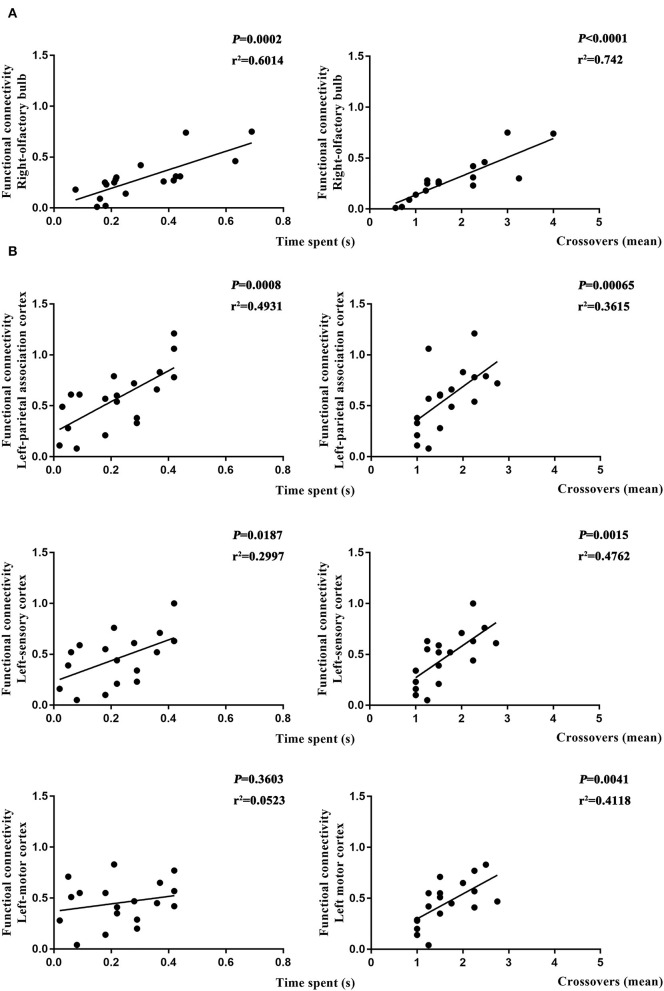
Relationship between functional connectivity (FC) and behavior performances on day 7. (A) Correlation analysis in L and NS groups. (B) Correlation analysis in L and L + S groups. Pearson's correlation was used with p < 0.05 for statistical significance and r2 for correlation.